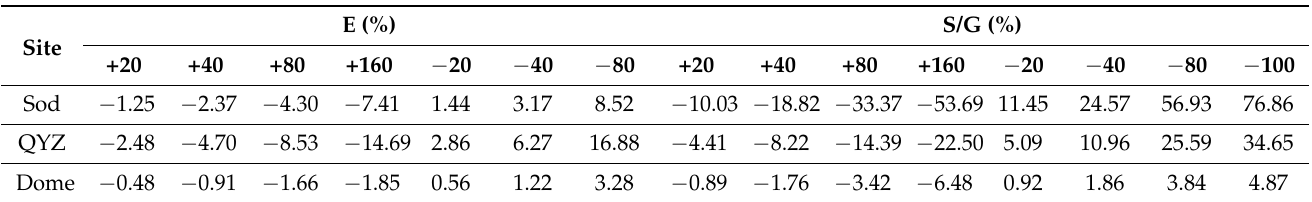
Table 9. Change rate of G (%) due to changes in E or S/G (%), with S/G or E retaining their original values. The change rate of G was computed using (G caln − G cal ) × 100/G cal , where G caln is G cal using new E or S/G, and G cal is the previous estimation using original values of E and S/G.